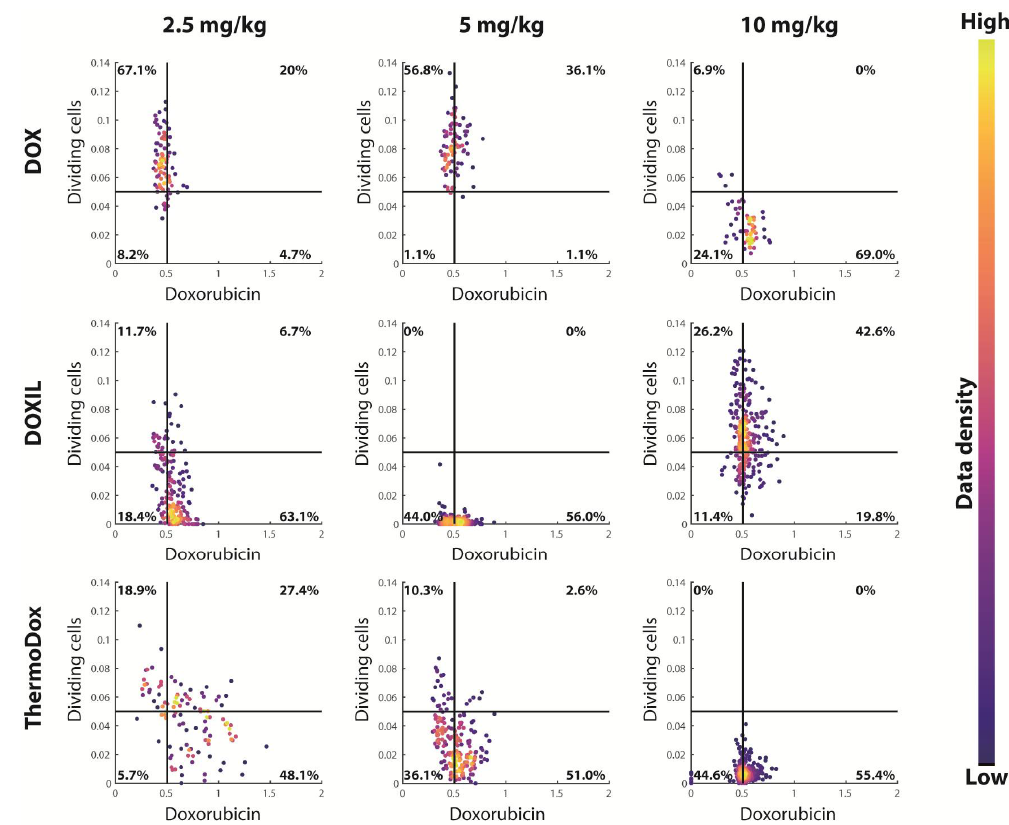
Figure 6. Correlation between dividing cell fraction and doxorubicin intensity. For each region in the tumor, the dividing cell fraction and the mean doxorubicin intensity were determined and are represented by one dot in the scatterplot. The color of the dots represents the data density of the locations. Dividing cell fraction below 0.05 and doxorubicin intensity below 0.5 were considered low.